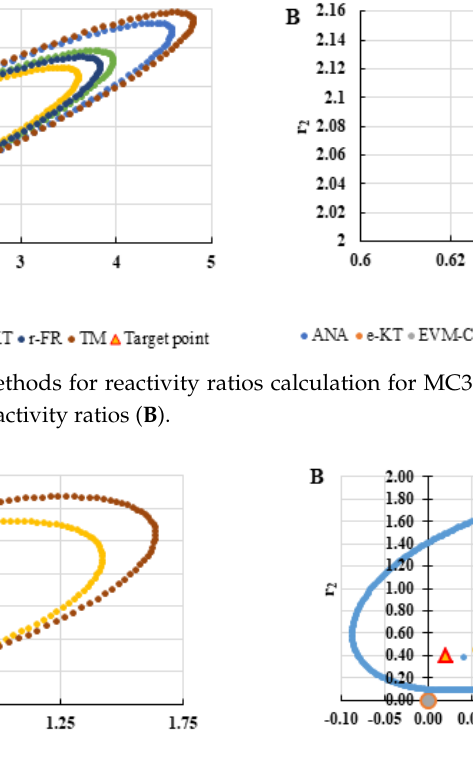
Figure 16. The JCR of analyzed methods for reactivity ratios calculation for HC1 imposed condition ( A ) and detail of smallest JCR with distribution of reactivity ratios ( B ).